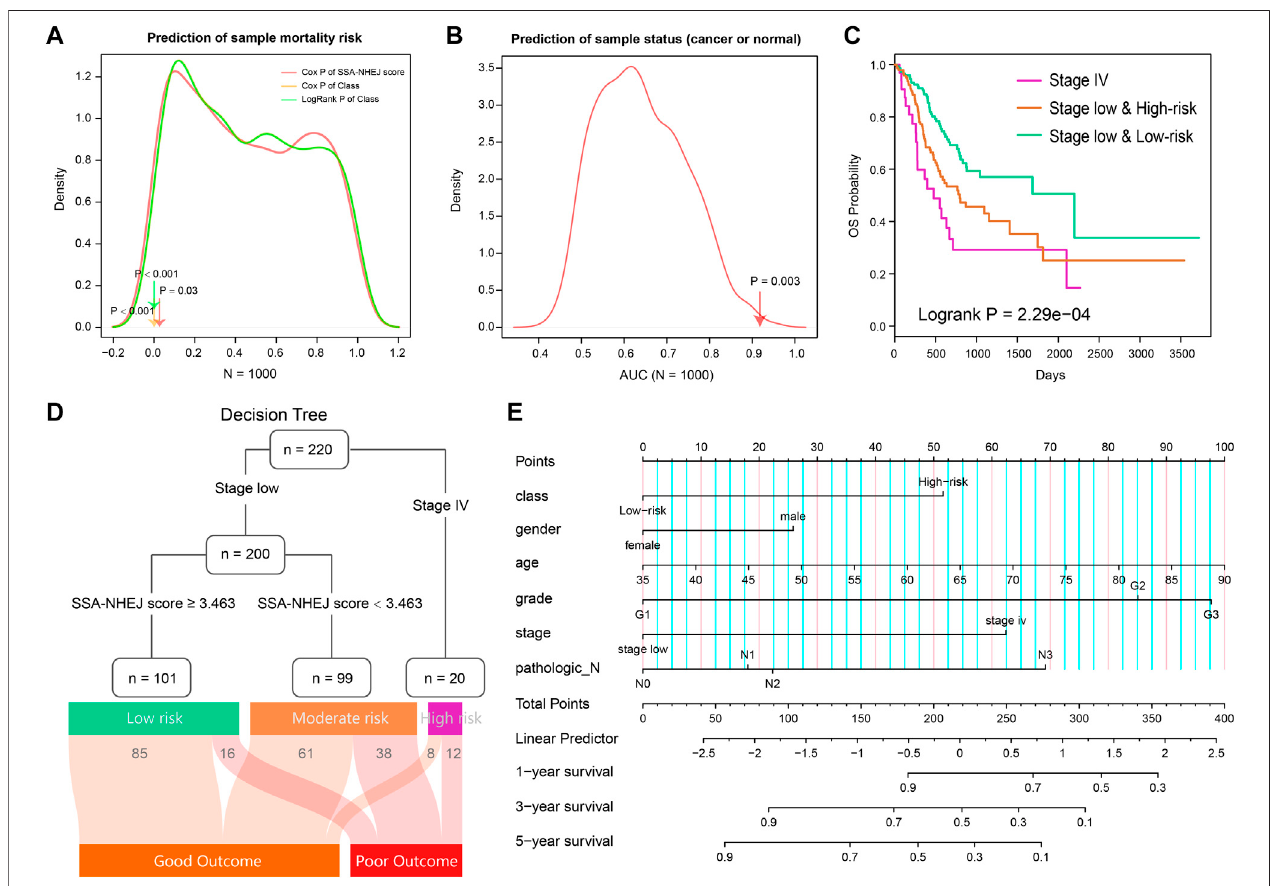
FIGURE 9 | Evaluation of two models and combing clinical features to predict risk assessment for individuals. (A) The prognosis of 1000 random HR-LR models basedontheexpressionofrandomgenesets. (B) AUCvaluesof1000randomCancer-Normalmodelsbasedontheexpressionofrandomgenesets. (C) Survivalplotof TCGA STAD patients classi fi ed by stage and SSA-NHEJ score. (D) Decision tree to predict the patient ’ s clinical outcome. The result of samples in the TCGA cohort is listed at to bottom. (E) A nomogram plot is constructed to quantify risk assessment for an individual patient.